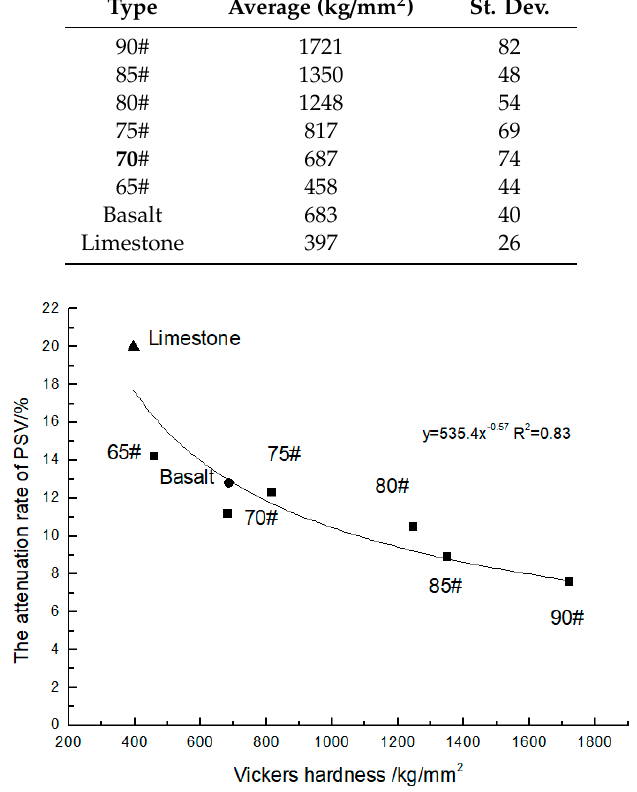
Figure 5. The relationship between Vickers hardness and the attenuation of PSV.